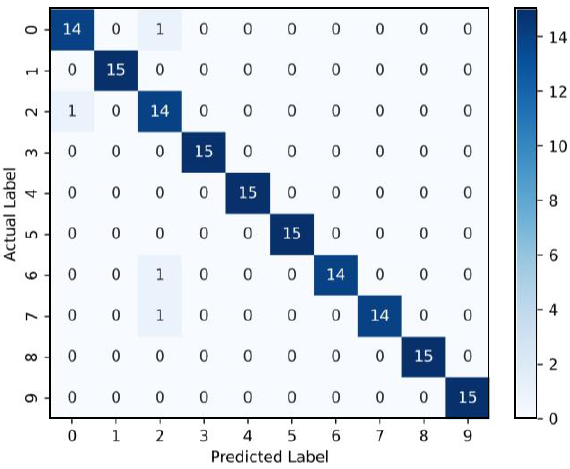
Figure 12. Multi-class confusion matrix of the proposed method.